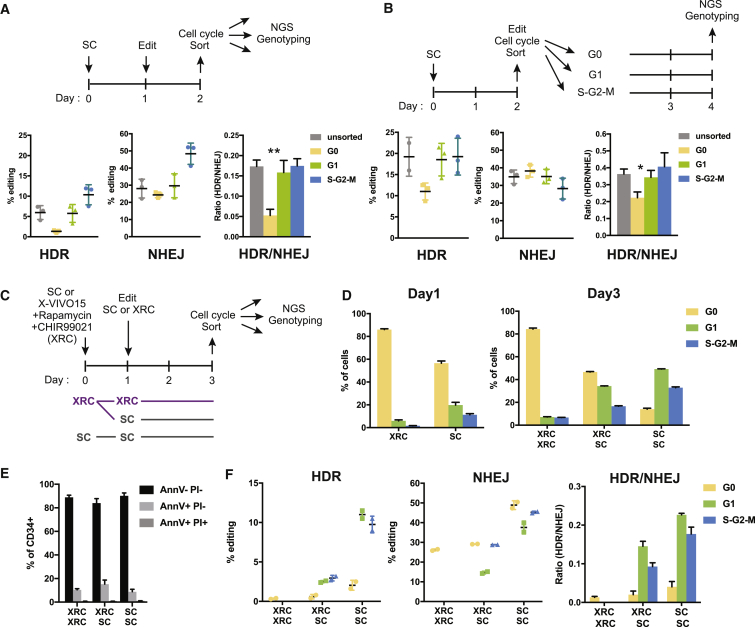
Quiescent CD34+ HSPCs Perform Only NHEJ, but Cycling CD34+ HSPCs Perform Both NHEJ and HDR(A) Editing outcomes in CD34+ subpopulations in different cell cycle status. One day post-electroporation and 2 days in culture. Percentage of reads positive for HDR or NHEJ by next-generation amplicon sequencing at the HBB site. G0 CD34+ HSPCs in 2-day culture do not accumulate HDR alleles. Representative data from experiments performed with three different mPB donors and n = 3 biological replicates per donor. Mean ± SD shown. ∗∗p < 0.01 by unpaired t test.(B) Editing outcomes in CD34+ subpopulations sorted into different cell cycle statuses. Two days post-electroporation and 4 days in culture. Percentage of reads positive for HDR or NHEJ by next-generation amplicon sequencing at the HBB site. G0 CD34+ HSPCs sorted at 2 days in culture accumulate significant HDR alleles in 4-day culture. Representative data from experiments performed with three different mPB donors and n = 3 biological replicates per donor. Mean ± SD shown. ∗p < 0.05 by unpaired t test.(C) Schematic of the workflow for mTOR and GSK-3 inhibition with rapamycin and CHIR99021 (XRC) for inhibition of cell cycle entry. Culture condition are SFEMII + CC110 (SC) and X-VIVO15 + rapamycin + CHIR99021 (XRC).(D) Cell cycle profiles of CD34+ cells in SC or XRC at the time of electroporation (day 1) and two days post-nucleofection (day 3). XRC prevents cell cycle entry, but this can be reversed by placing the CD34+ cells in SC media. Representative data from experiments performed with three different mPB donors and n = 2 biological replicates per donor. Mean ± SD shown.(E) Percentage of early and late apoptosis was assessed by staining the cells for annexin V (AnnV) and propidium iodide (PI) at 2 days post-nucleofection. AnnV−PI−, viable; AnnV+PI−, early apoptotic; AnnV+PI+, apoptotic. XRC does not induce apoptosis. Representative data from experiments performed with three different mPB donors and n = 2 biological replicates per donor. Mean ± SD shown.(F) Editing outcomes in CD34+ cells kept in SC media or XRC in different cell cycle status 2 days post-nucleofection and 3 days in culture. Inhibition of cell cycle entry by XRC blocks HDR repair but is reversible. Representative data from experiments performed with three different mPB donors and n = 2 biological replicates per donor. Mean ± SD shown.See also Figure S3.